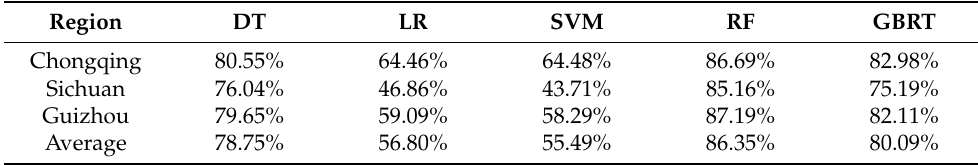
Table 4. Accuracy evaluation of five machine learning models in the three regions. Table 5. Accuracy evaluation of five machine learning models in the three regions.